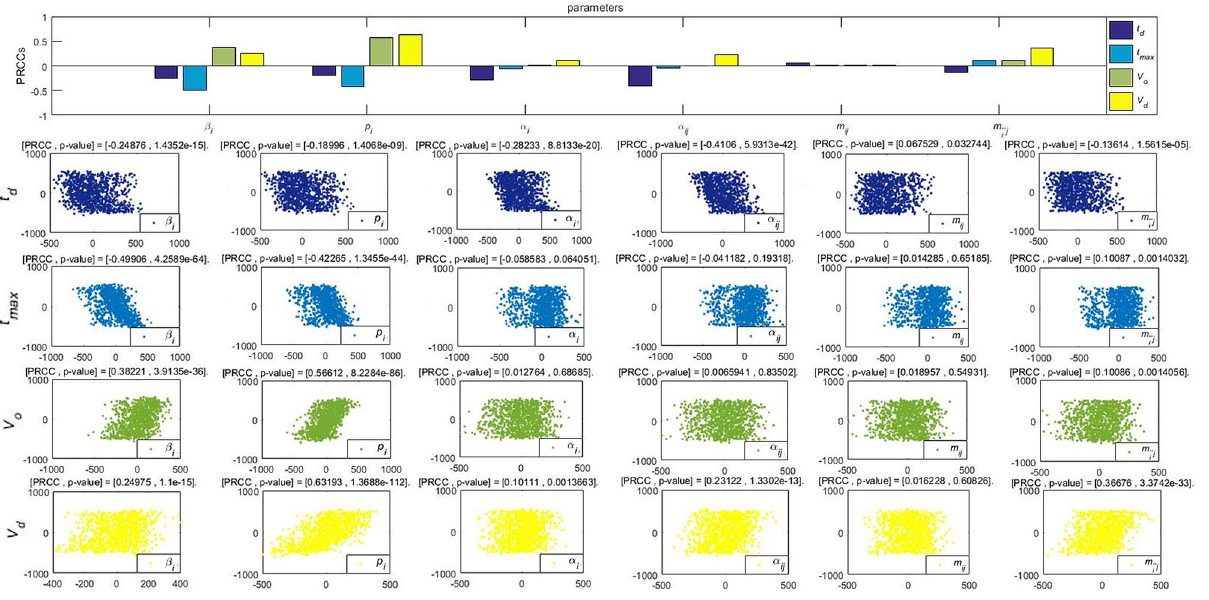
Figure 17. PRCC results and PRCC scatter plots with indexes t d , t max , V o and V d of different